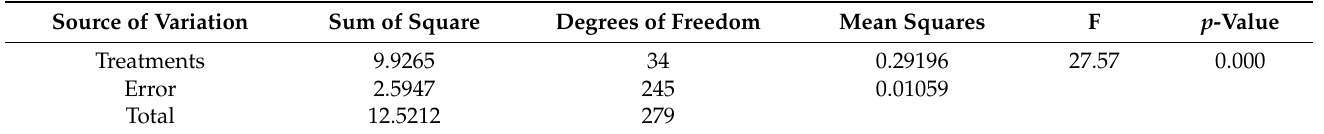
Table 11. ANOVA analysis for the spectral